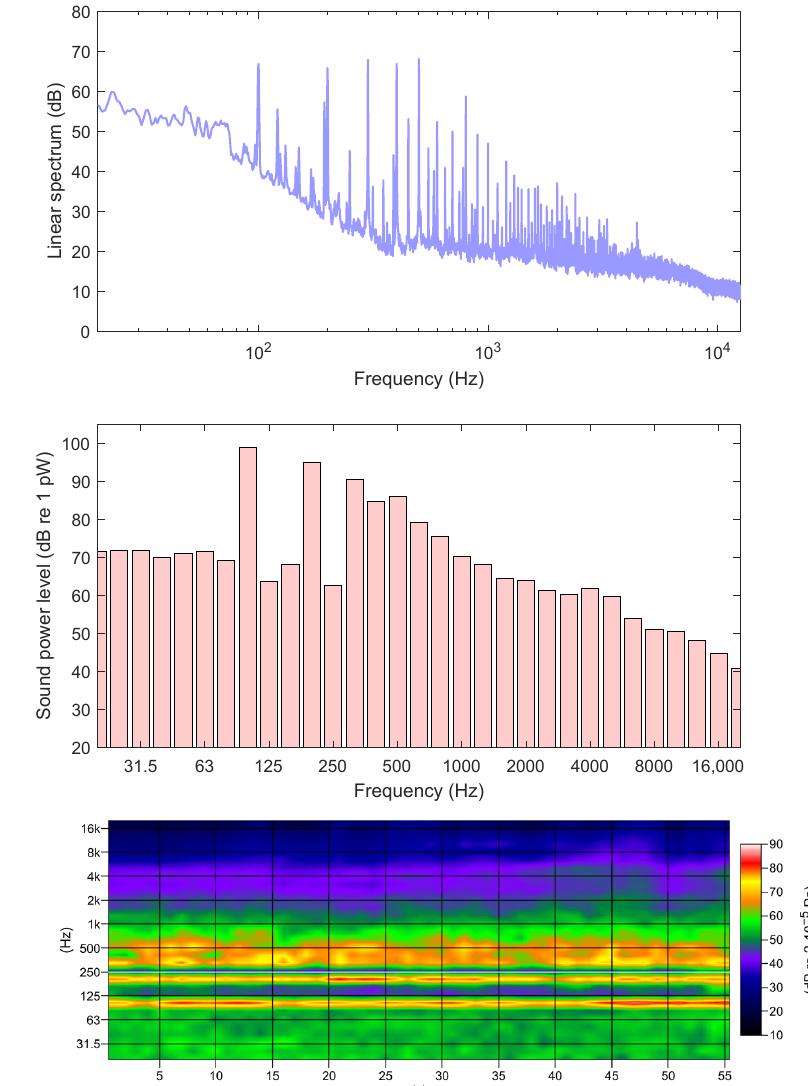
Figure 3. Characteristics of TR1 transformer. From top to bottom: sound pressure level spectrum at 5 m from the transformer’s case; sound power spectrum;